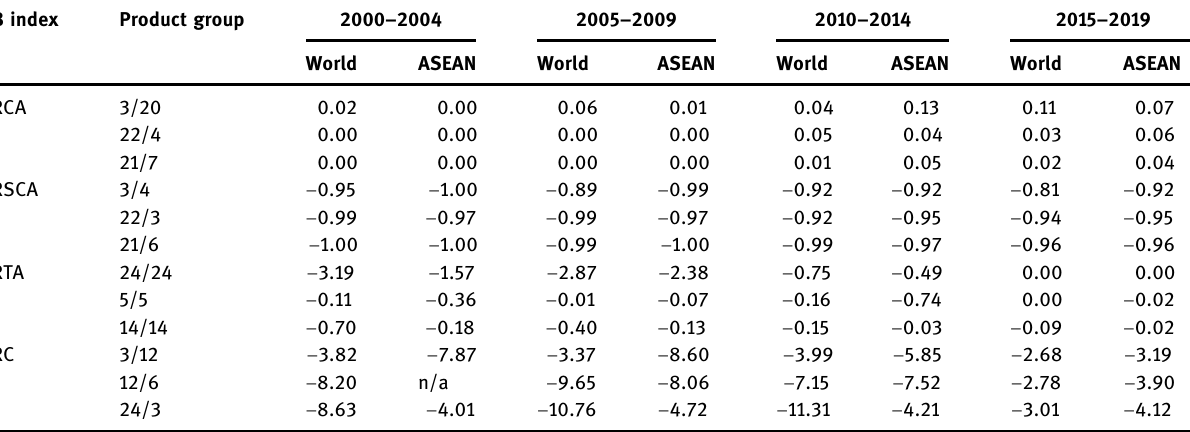
Table 4: The three highest Balassa indices of Brunei at World and ASEAN level, 2000 – 2019